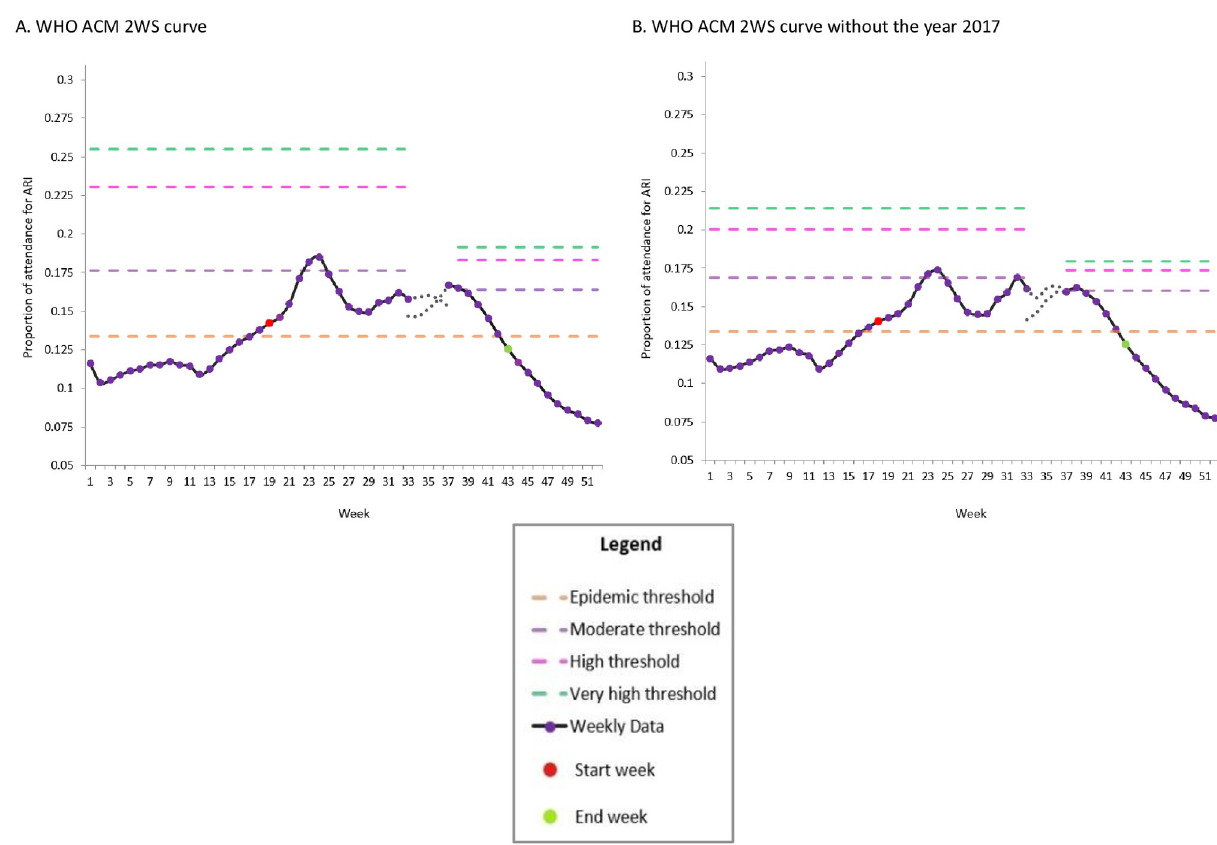
Fig 2. Comparative analysis for the two wave/season curve of the proportion of attendance for ARI in Mauritius using WHO ACM.